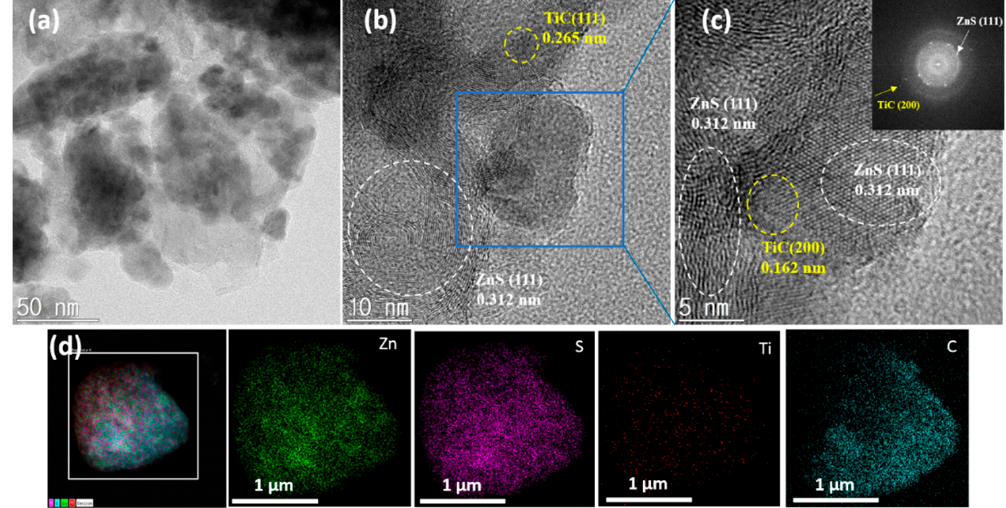
Figure 3. (a–c) TEM and HRTEM images of the ZnS-TiC-C composite; and (d) STEM image with EDS Figure 3. ( a – c ) TEM and HRTEM images of the ZnS-TiC-C composite; and ( d ) STEM image with EDS mapping images of the ZnS-TiC-C composite. mapping images of the ZnS-TiC-C